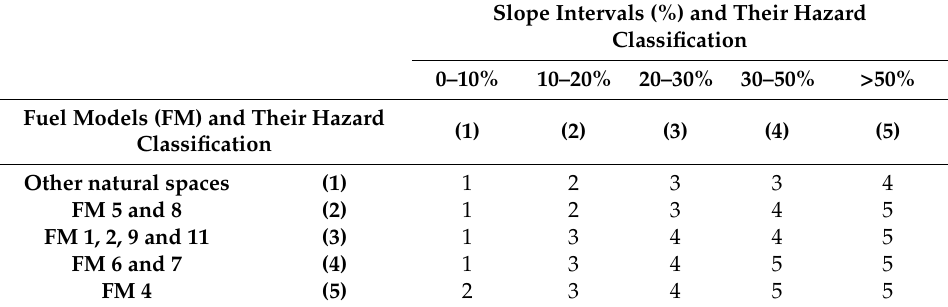
Table 4. Structural hazard.